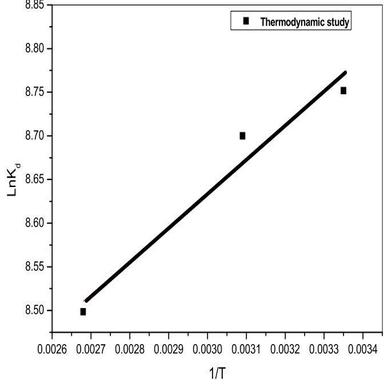
Thermodynamic chart of Mo(VI) sorbed onto mesoporous MnO2/ MWCNTs at pH = 2, v/m = 0.333 L g− 1 , and Co = 10 mmolL− 1 of Mo(VI).